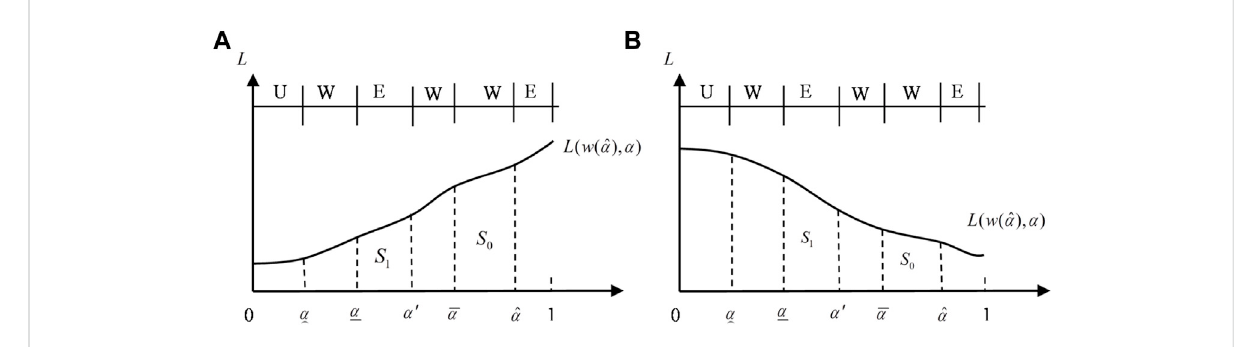
FIGURE 3 Staggered career choices along with the strength of social